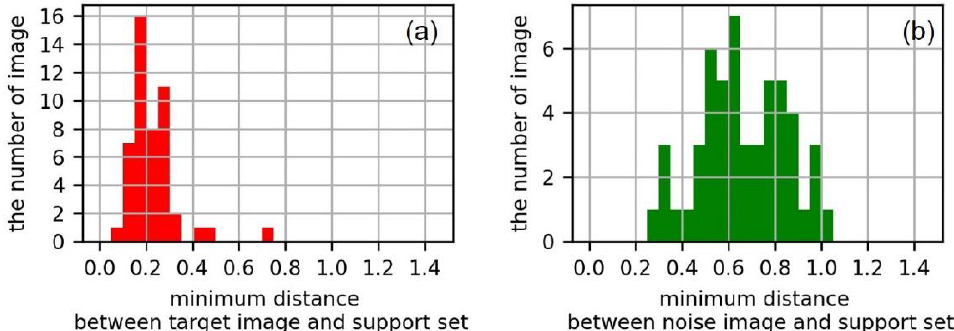
Figure 13. Histogram of Insadong: ( a ) minimum distance between a target photo set and reference set; ( b ) minimum distance between a noise photo and reference set.